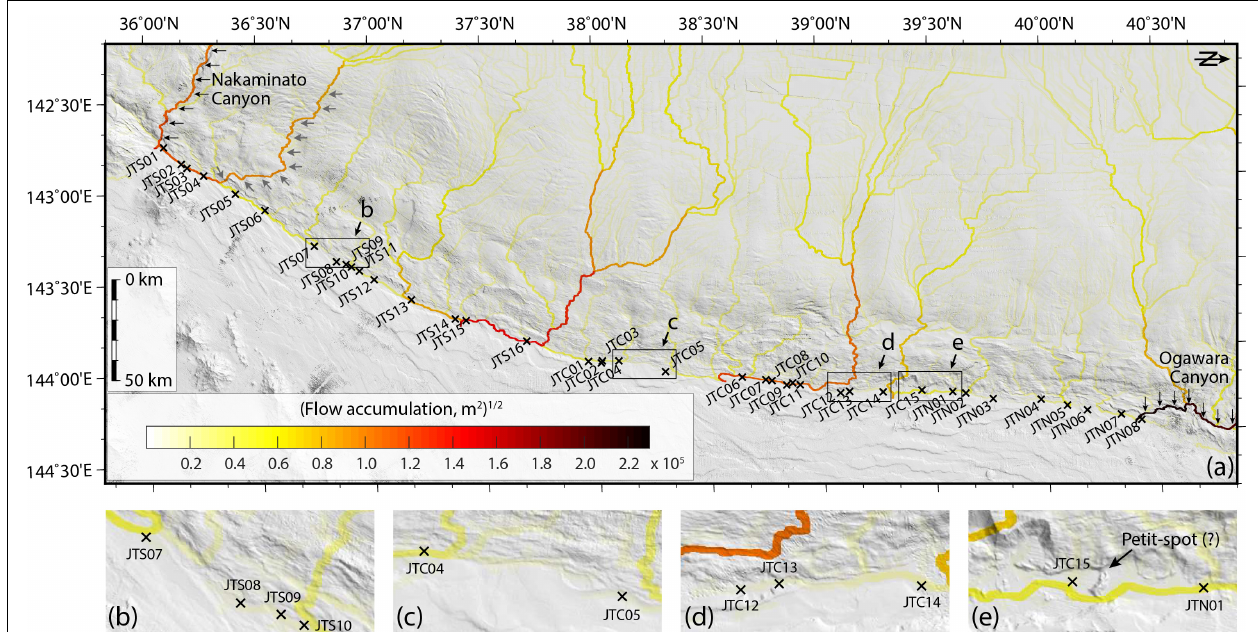
FIGURE 2 | Flow accumulation in (a) the entire Japan Trench, (b) the southern Japan Trench, (c,d) the central Japan Trench, and (e) petit-spot area. The square root of flow accumulation (m 2 ) is shown for the presentation purpose. The identified isolated fill-basins are also shown (see Figure 3